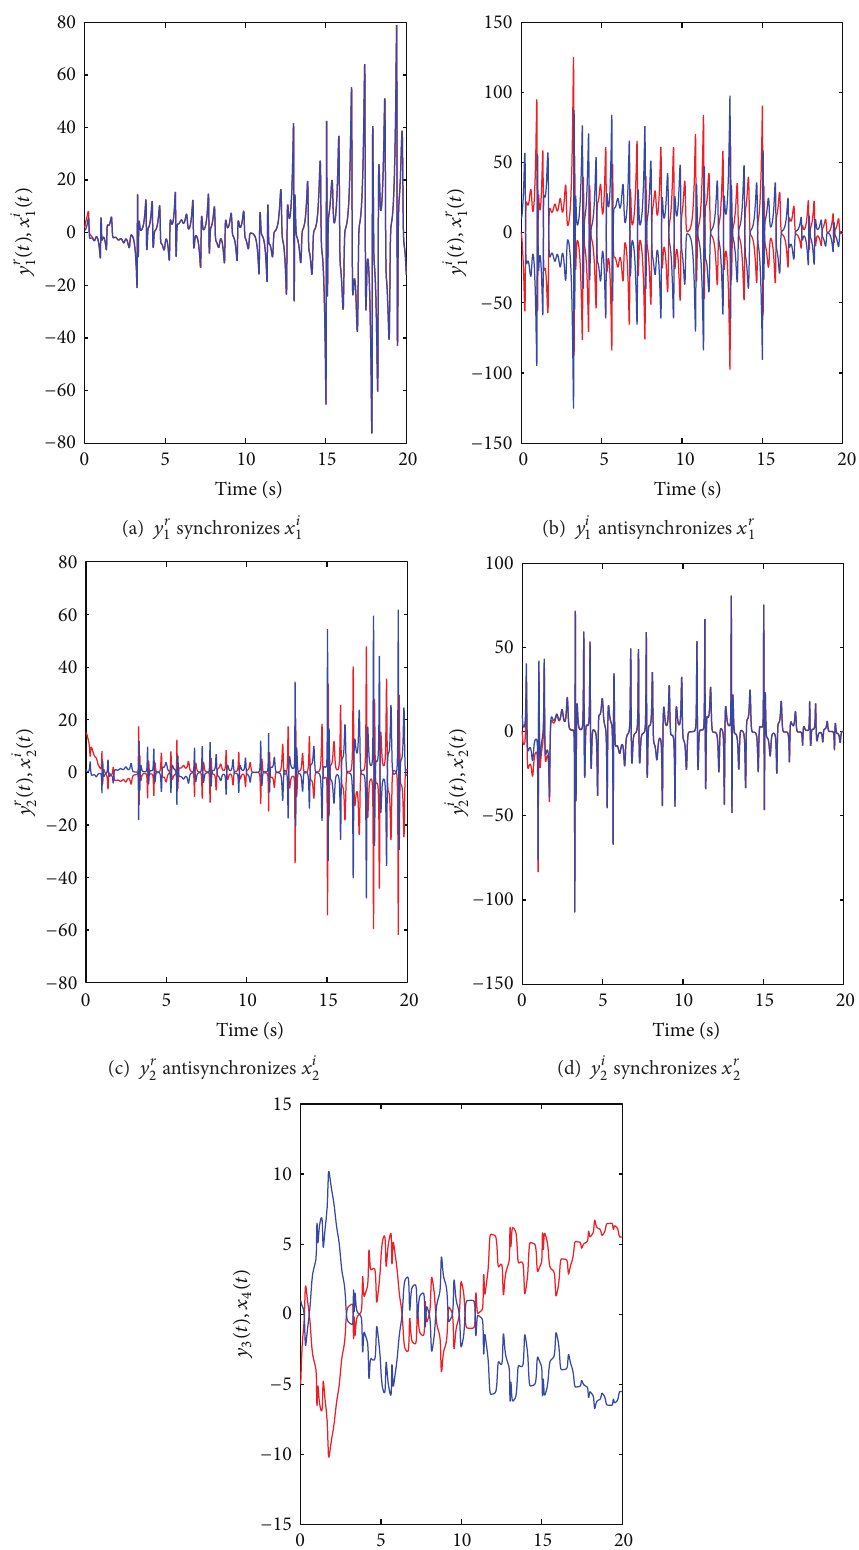
Figure 6: Reduced order synchronization—CMHPS between 4-dimensional complex hyperchaotic Dadras drive system (29) (blue line) and 3-dimensional complex chaotic Lorenz response system (31) (red line) with the controller